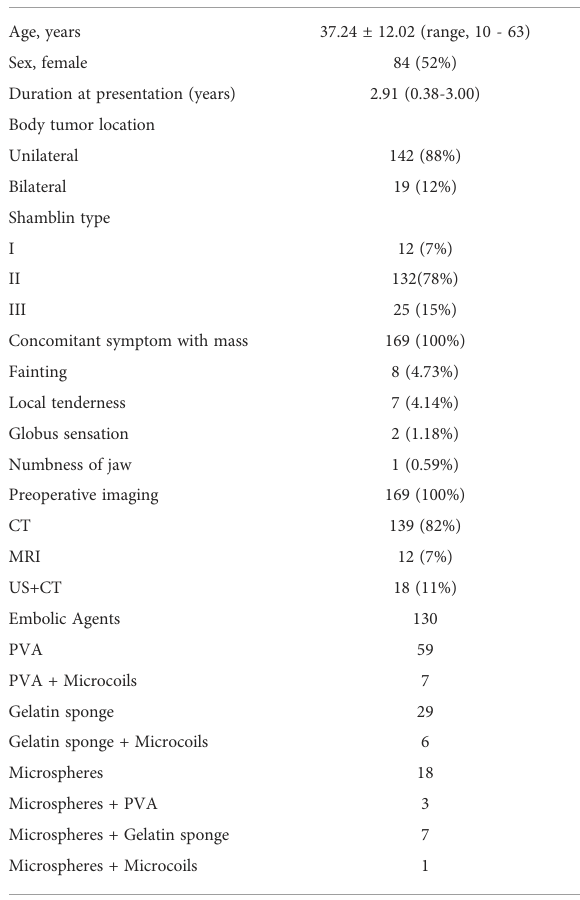
TABLE 1 Demographic and clinical characteristics of study population (161 patients, 169